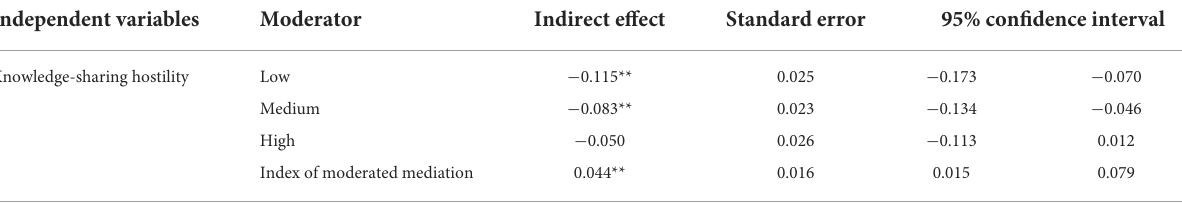
TABLE 6 Mediating effect of knowledge manipulation on different levels of coordination